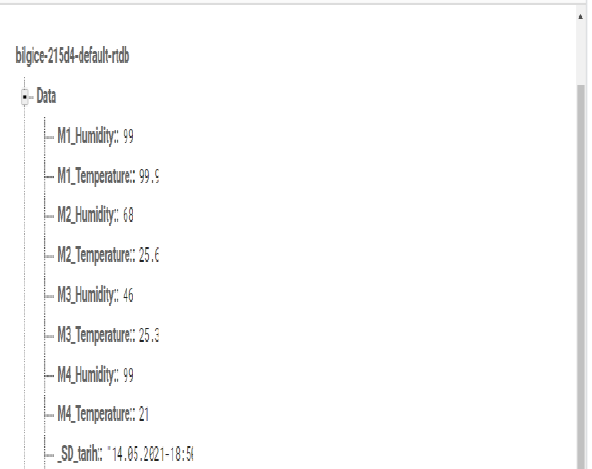
Figure 2.6. Firebase realtime database screen.